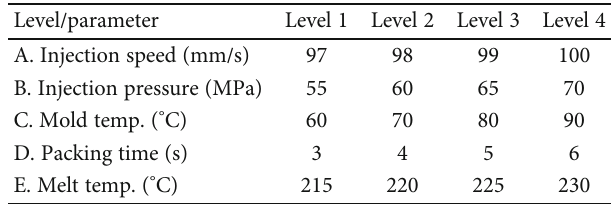
Table 1: Process parameters for thin-wall injection molding using ABS+PC materials.